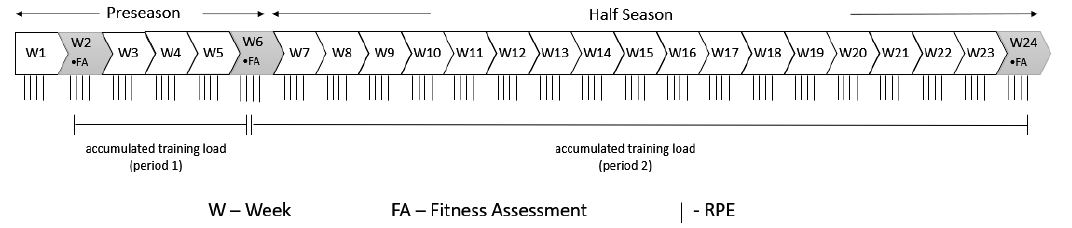
Figure 1. Timeline of the